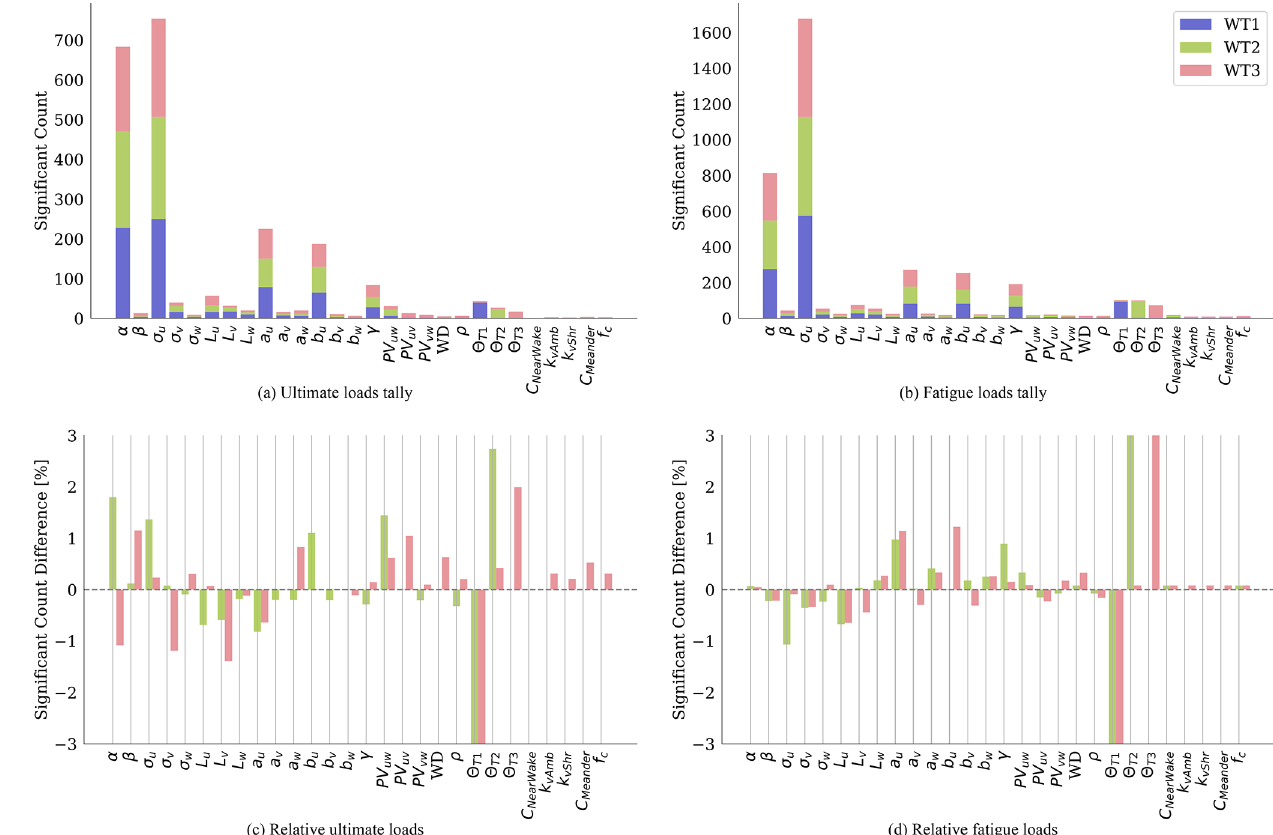
Figure 5. Significant parameter count from ultimate (a, c) and fatigue (b, d) loads. Each color represents a different wind turbine. The top row (a, b) shows the significant event counts for all turbines, and the bottom row (c, d) shows the percent difference in significant event counts for WT2 and WT3 relative to WT1. For the (cid:50) input parameters, the values in panels (c) and (d) can extend to nearly ± 100%. However, the axes of these figures have been reduced to better focus on the impact of more input parameters. Table 5. Percentage of contribution to total number of significant events for fatigue and ultimate loads. Cells are colored by the percentage value, with darker blue representing a higher